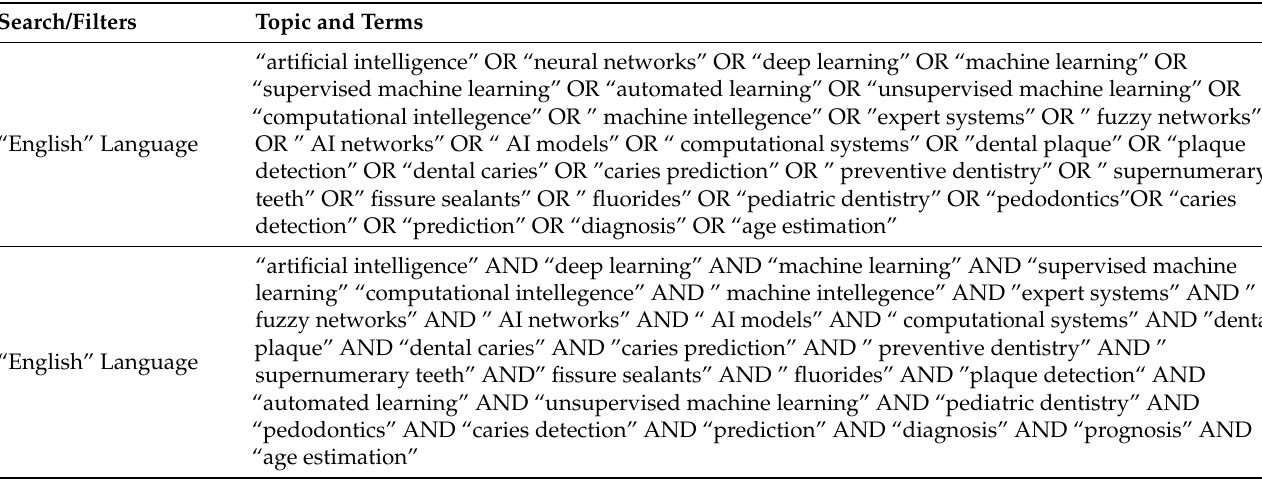
Table A1. Structured search strategy carried out in electronic databases. Table A1. S tructured search strategy carried out in electronic databases.